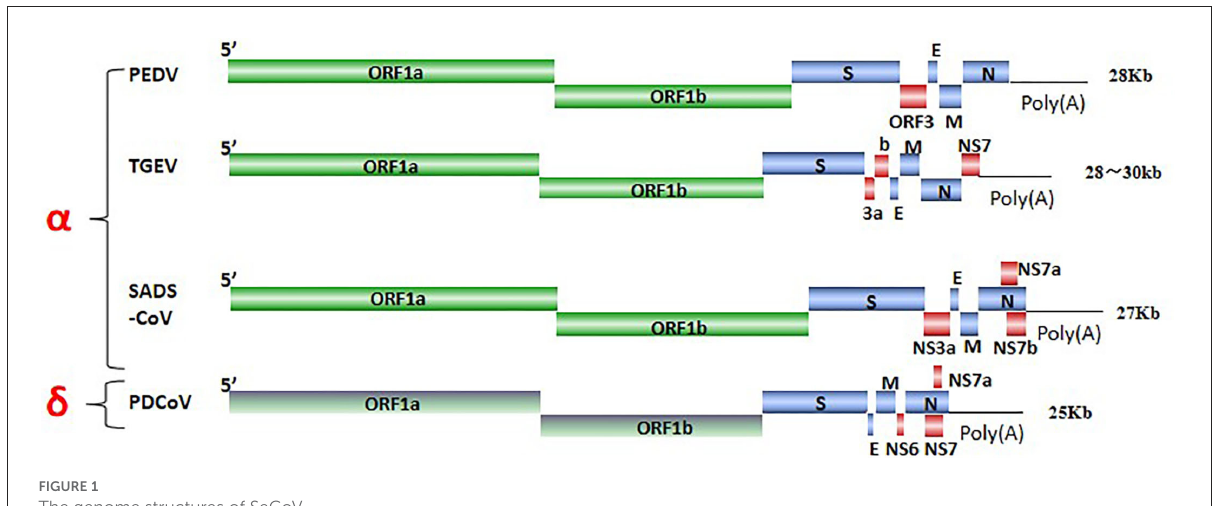
FIGURE1 The genome structures of